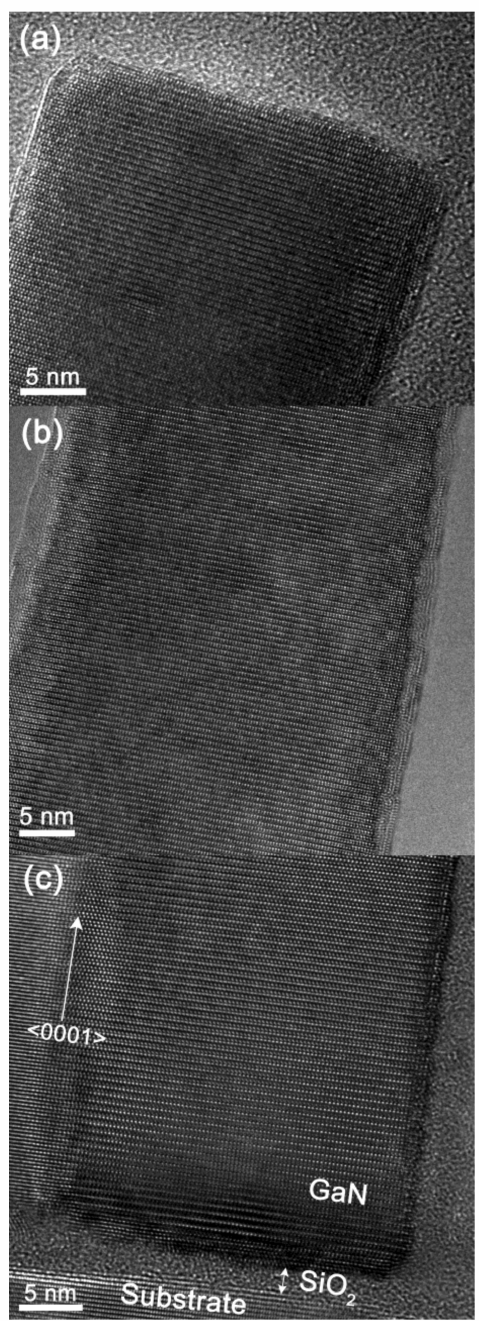
Figure 7. Cross-sectional HRTEM images from the GaN nanorod grown at P N2 = 2.5 mTorr on Si(111) substrate showing ( a ) the top part of the nanorod; ( b ) the middle part of the nanorod; and ( c ) the interface between the substrate and nanorods, containing the native oxide layer at the